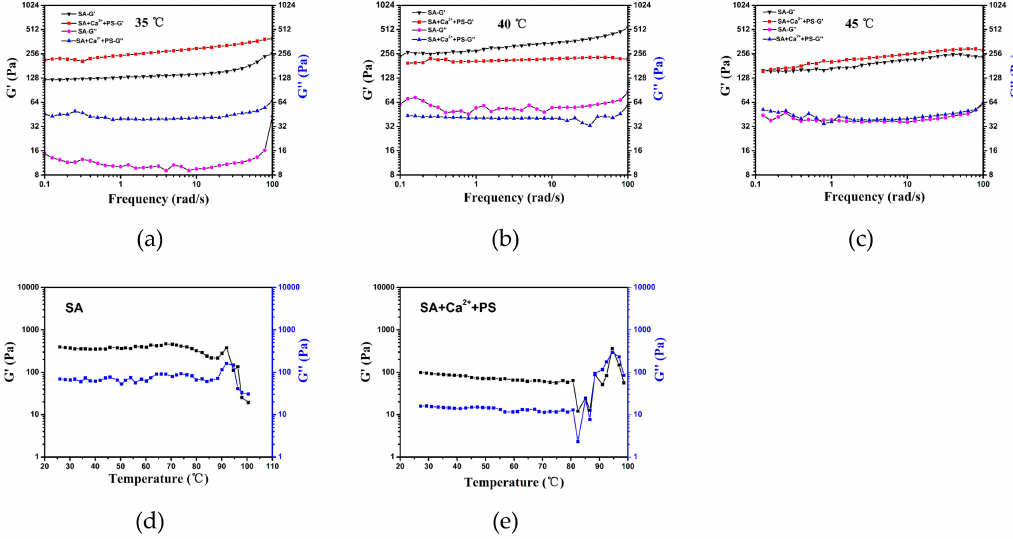
Figure 3. Rheological study of thermo-responsible phospholipid microcapsule-alginate composite hydrogel at 35 ◦ C ( a ), 40 ◦ C ( b ), 45 ◦ C ( c ), and temperature programming between SA ( d ) and SA + Ca 2 + + PS ( e ).